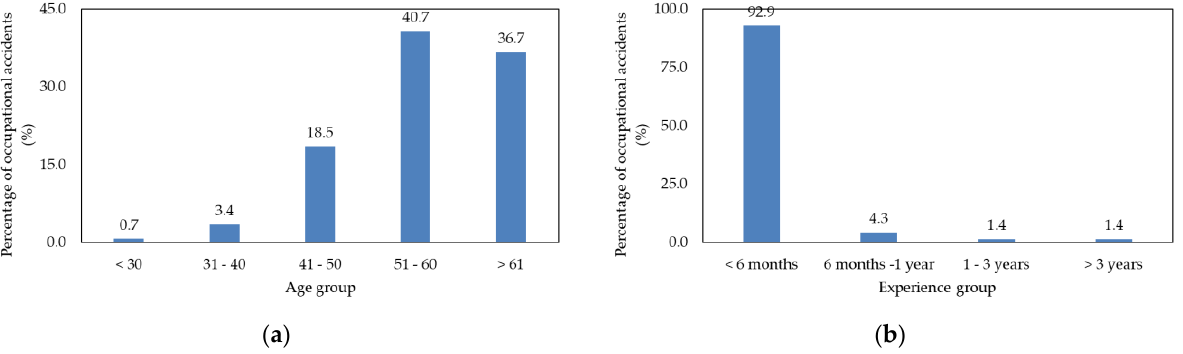
Figure 2. Distribution of occupational accident rates annually between 2010 and 2020: ( a ) age of workers and ( b ) experience of workers.